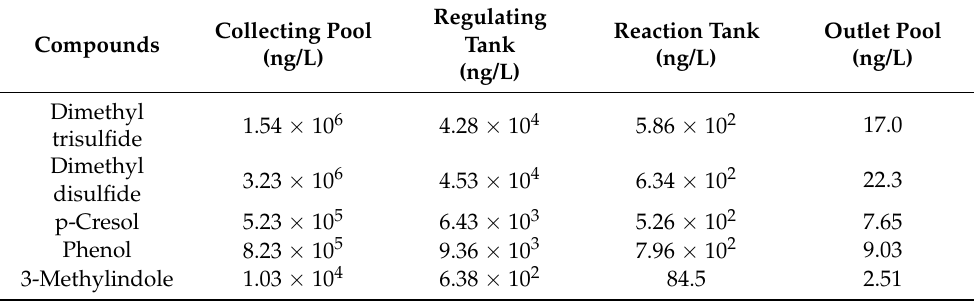
Table 2. Detection results and recoveries of volatile metabolites in water samples ( n =